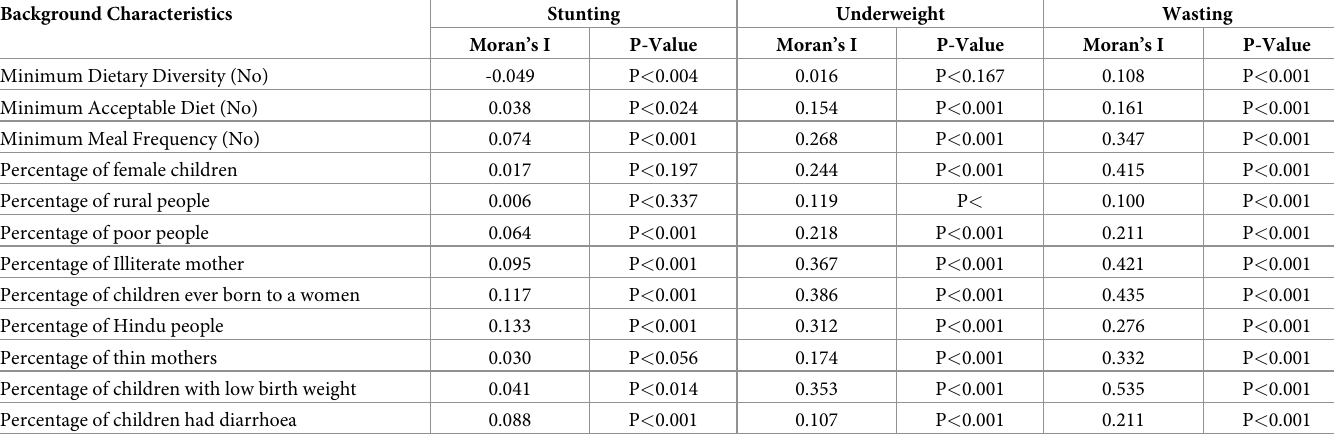
Table 4. Bivariate Local Moran’s I results for all districts (n-640) among children aged 6–23 months, India, 2015–16.